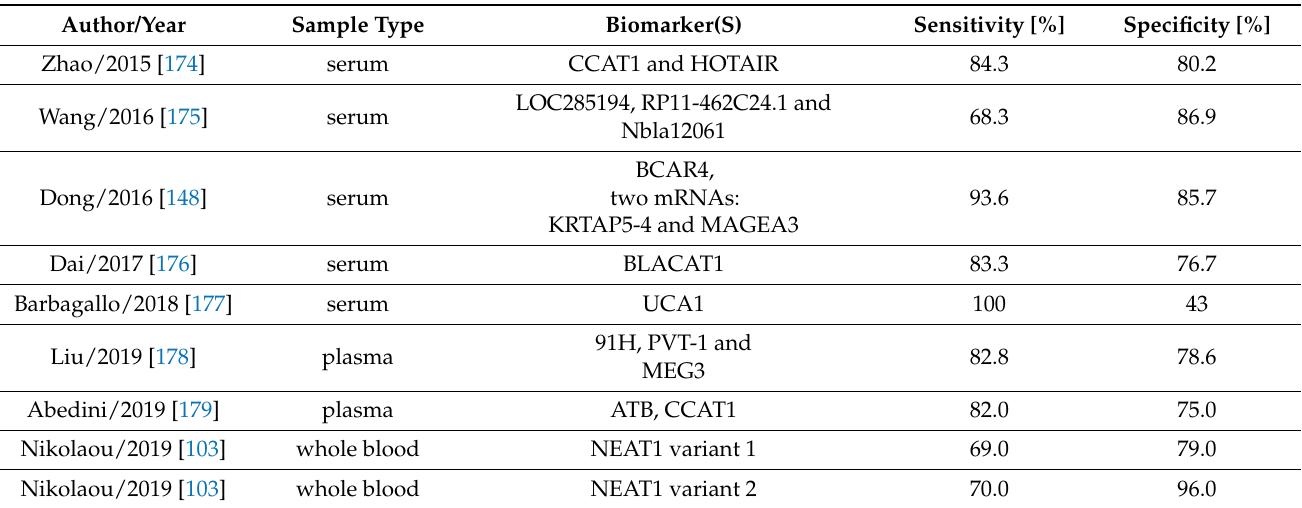
Table 5. According to Loktionov in modification: long non-coding RNA biomarkers used for CRC detection